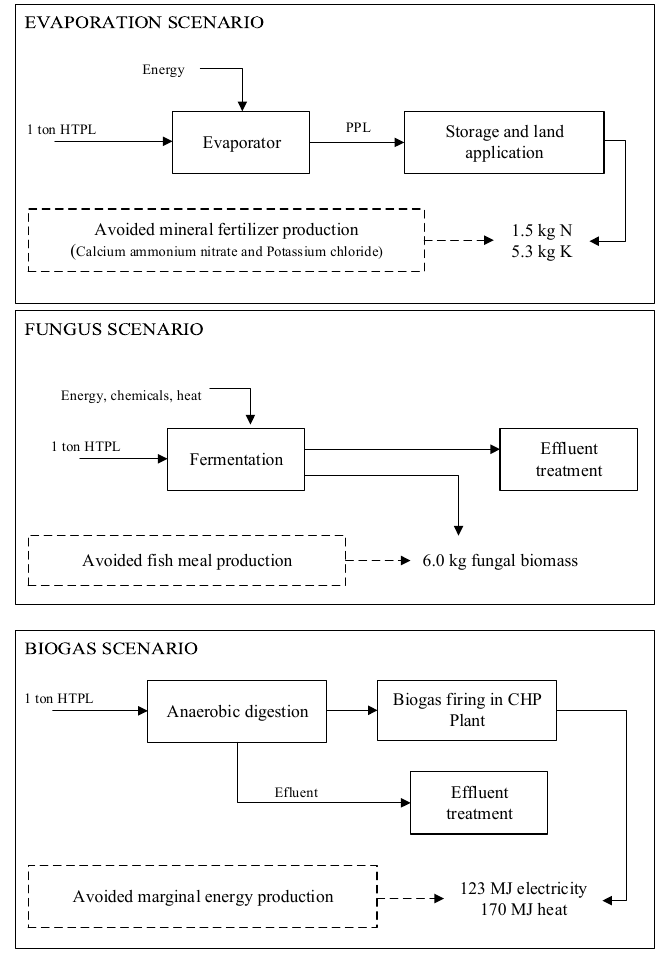
Figure 2. System boundaries and reference flows for the evaporation, fungus and biogas scenarios. The dotted lines show the avoided products in the system expansion. Table 5. Biochemical composition of the fungal biomass and the substituted products.